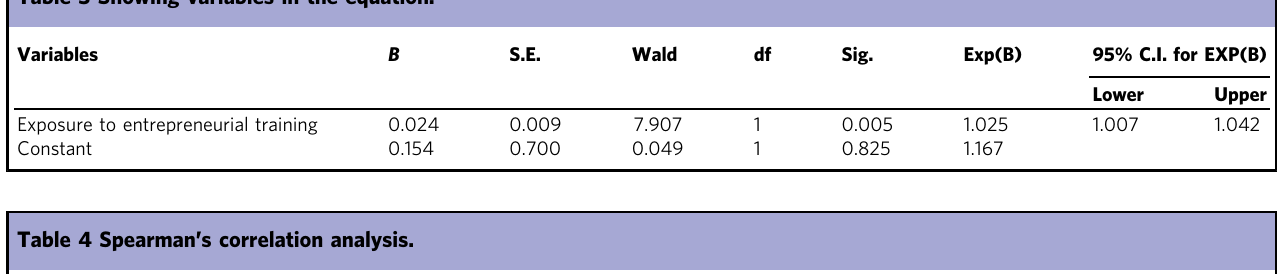
Table 3 Showing variables in the equation.